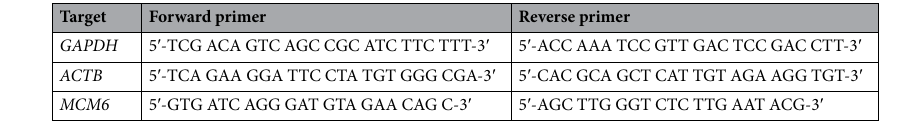
Table 3. Primer sequences for the studied